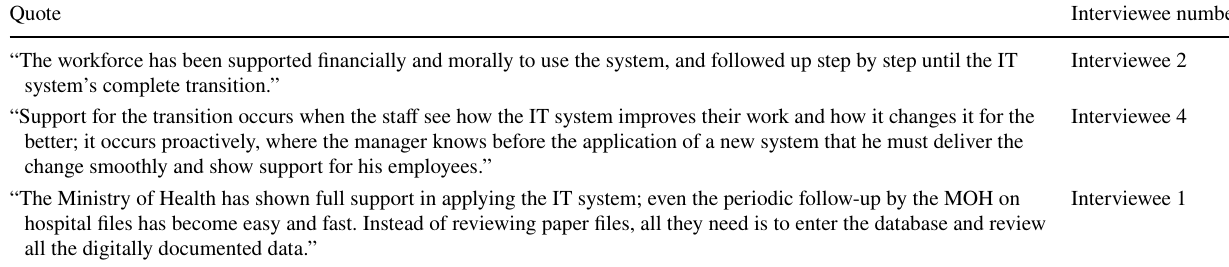
Table 7 Solutions for IT implementation through